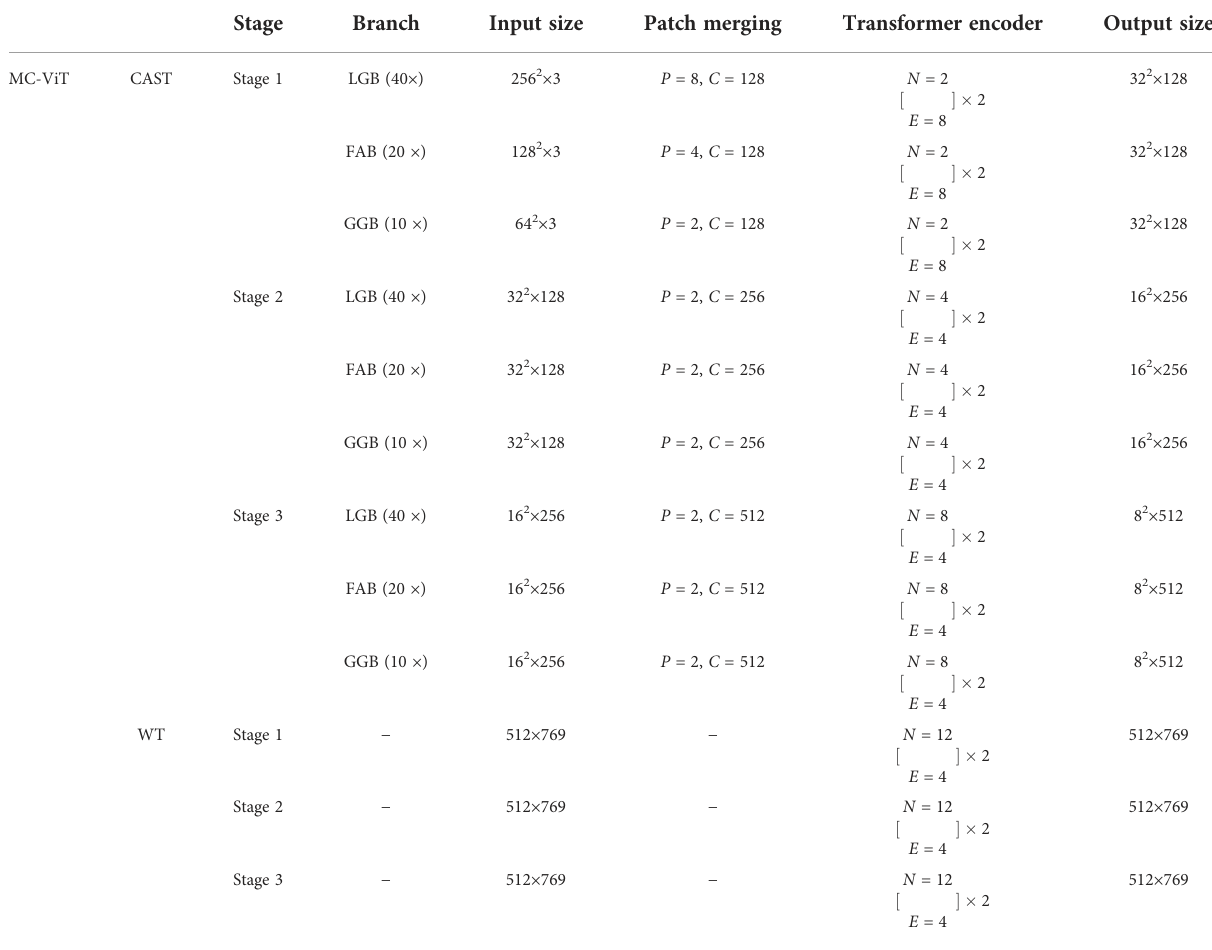
TABLE 2 The network con fi gurations of the proposed MC-ViT, where P , C , N , and E indicate the patch size, the channel number of the output, the head number of transformer block, and the expansion ratio of MLP, respectively.